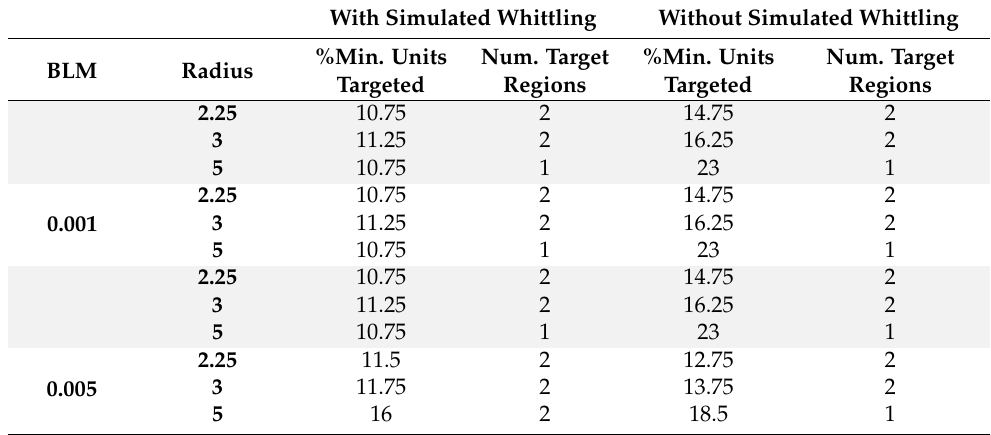
Table 1. Efficiency data for the 24 optimal portfolios designated for sets of MinPatch portfolios produced through applying Marxan + MinPatch to a simulated dataset with a target case percentage of 50%. With Simulated Whittling Without Simulated Whittling %Min. Units Num. Target %Min. Units Num. Target BLM Radius Targeted Regions Targeted Regions 2.25 10.75 2 14.75 2 3 11.25 2 16.25 2 0 5 10.75 1 23 1 2.25 10.75 14.75 3 11.25 2 16.25 2 0.001 5 10.75 1 23 1 2.25 10.75 2 14.75 2 3 11.25 2 16.25 2 0.002 5 10.75 1 23 2.25 11.5 12.75 3 11.75 2 13.75 2 0.005 5 16 2 18.5 1